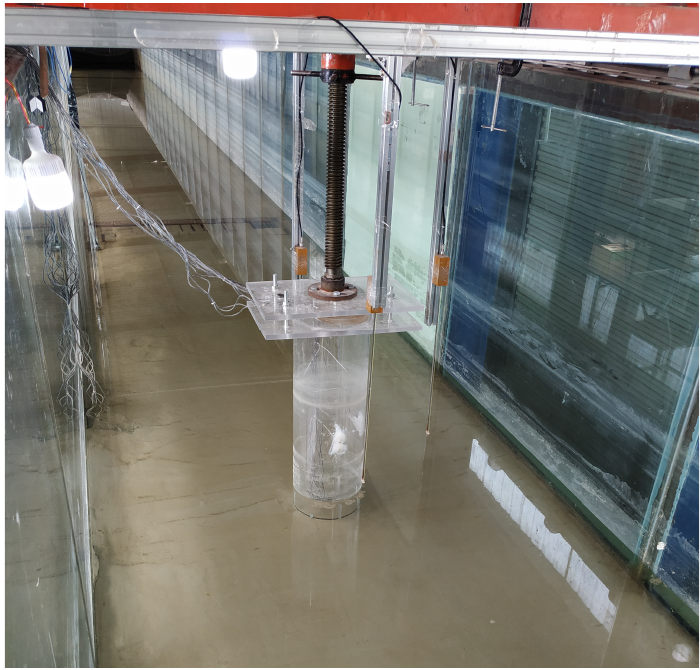
Figure 1. A photo of the experimental